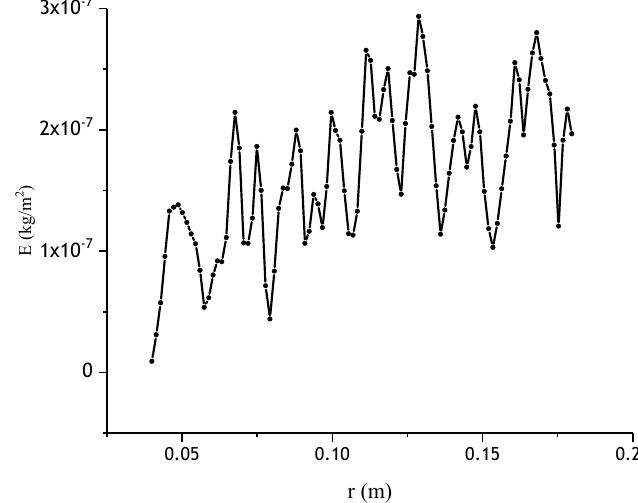
Figure 9. Change of wear E with radius of